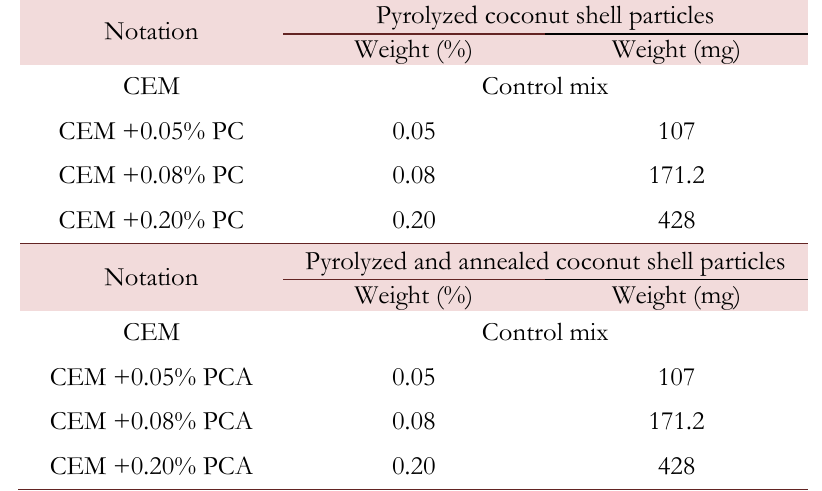
Table 3: Composition of cement composite